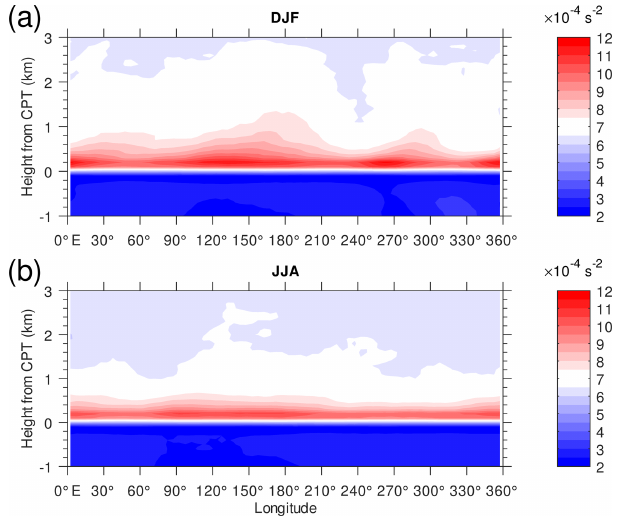
Figure 4. Height–longitude cross sections of the mean N 2 over 10 ◦ S–10 ◦ N latitude relative to the CPT location in the vertical for (a) DJF and (b) JJA. Color contour interval is 0 . 5 × 10 − 4 s − 2